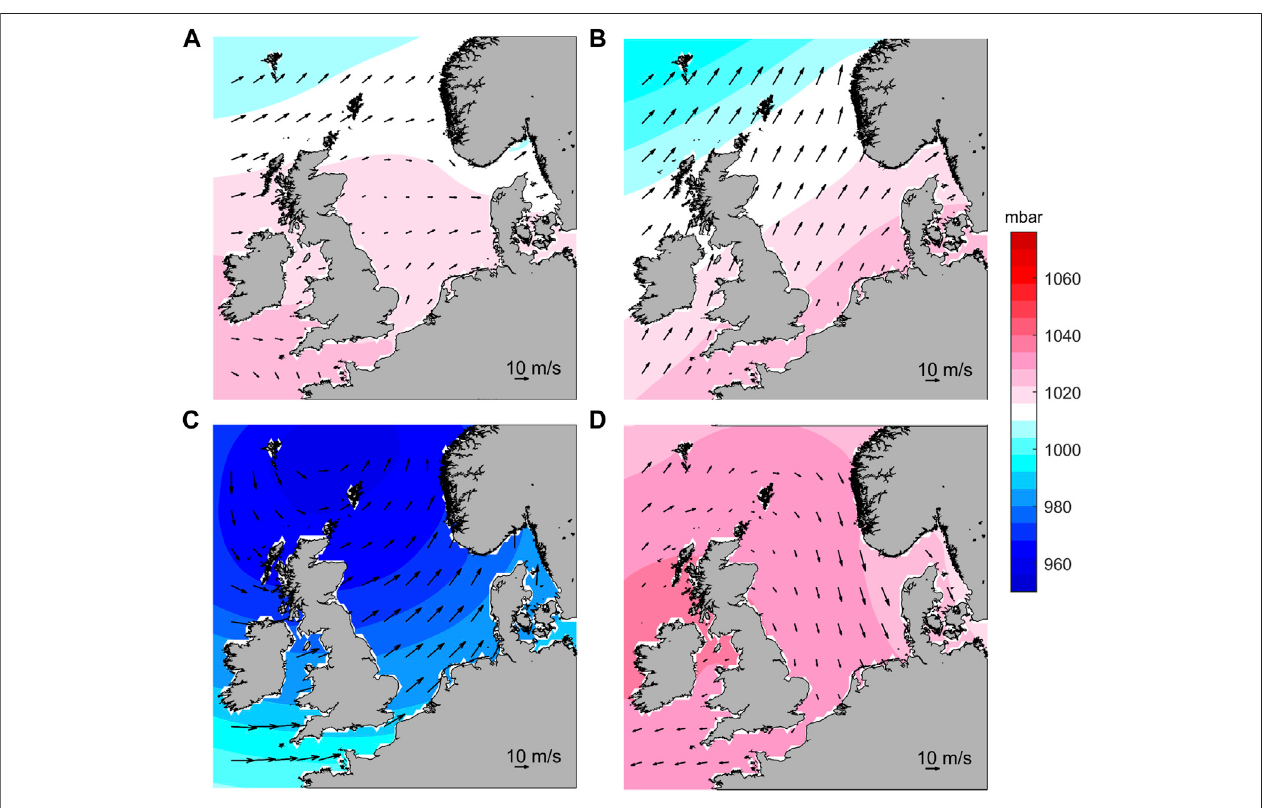
FIGURE6| Sealevelatmosphericpressure andsurfacewind speed fi eldsofWT55 (A) ,WT65 (B) ,WT4 (C) ,and WT53 (D) .WT55 (A) andWT65 (B) representthe most frequent pattern at annual and winter scale, respectively. WT4 (C) and WT53 (D) show cyclonic and anticyclonic situations, respectively.